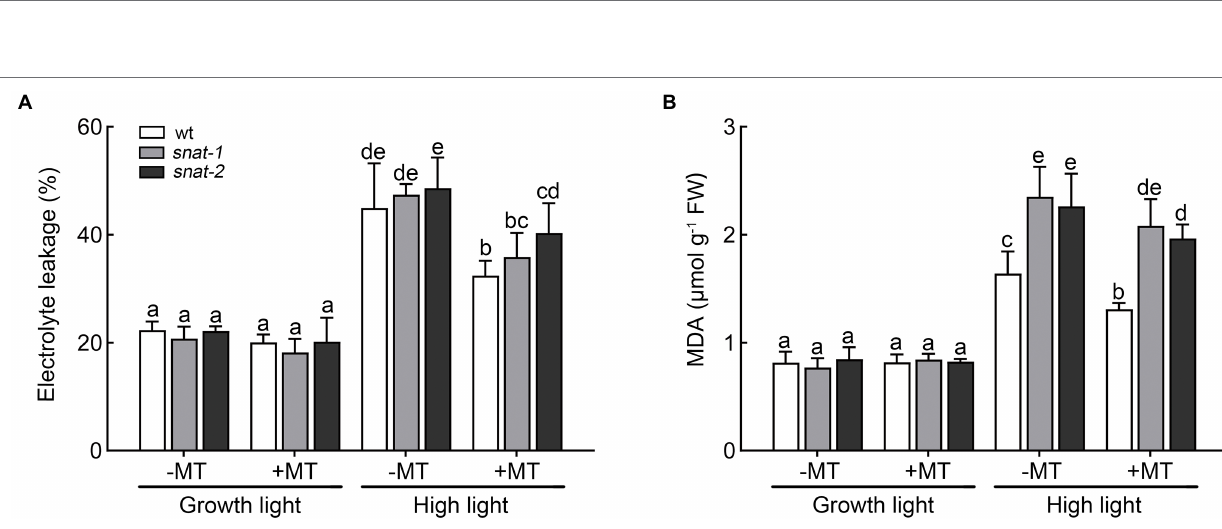
FIGURE 5 | Effects of exogenous melatonin on the damage of cellular membranes. (A) Electrolyte leakage (EL). (B) Malondialdehyde (MDA). Others are the same as in Figure 1